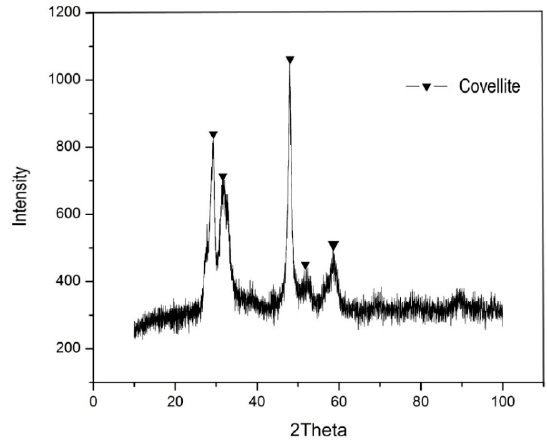
Figure 5. XRD analysis of residue for the baseline test.